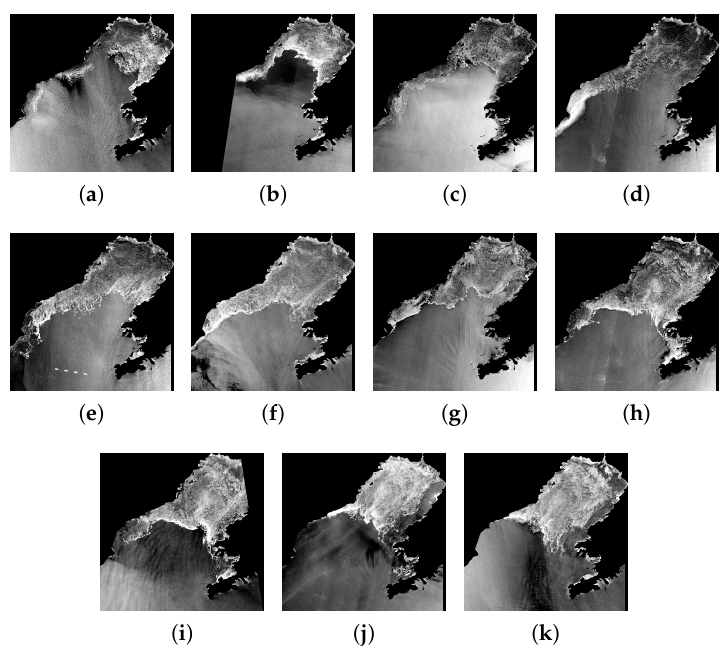
Figure 8. RADARSAT-2 ScanSAR Wide mode HH-polarization channel SAR imagery: ( a ) 2 january 2013; ( b ) 6 January 2013; ( c ) 9 January 2013; ( d ) 16 January 2013; ( e ) 23 January 2013; ( f ) 26 January 2013; ( g ) 2 February 2013; ( h ) 9 February 2013; ( i ) 12 February 2013; ( j ) 16 February 2013; ( k ) 19 February 2013; c (cid:13) MDA.